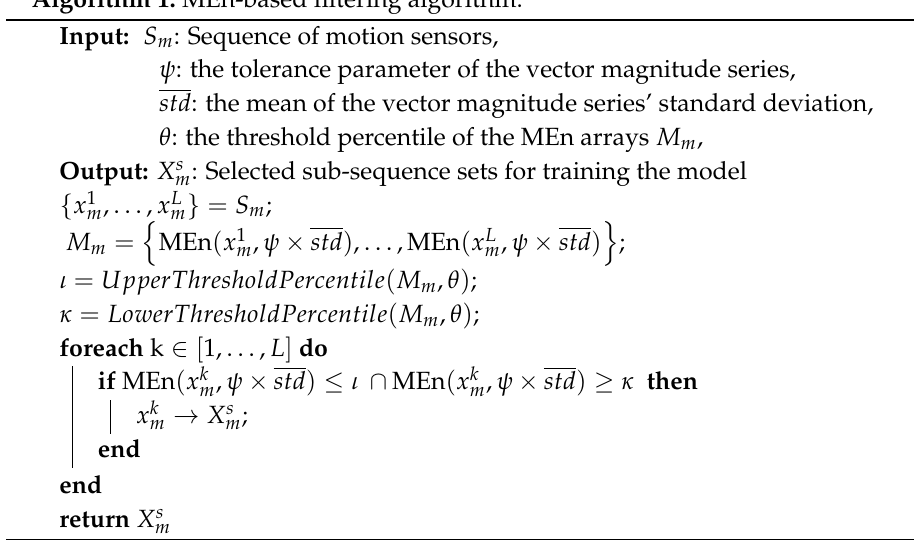
Algorithm 1: MEn-based filtering algorithm.